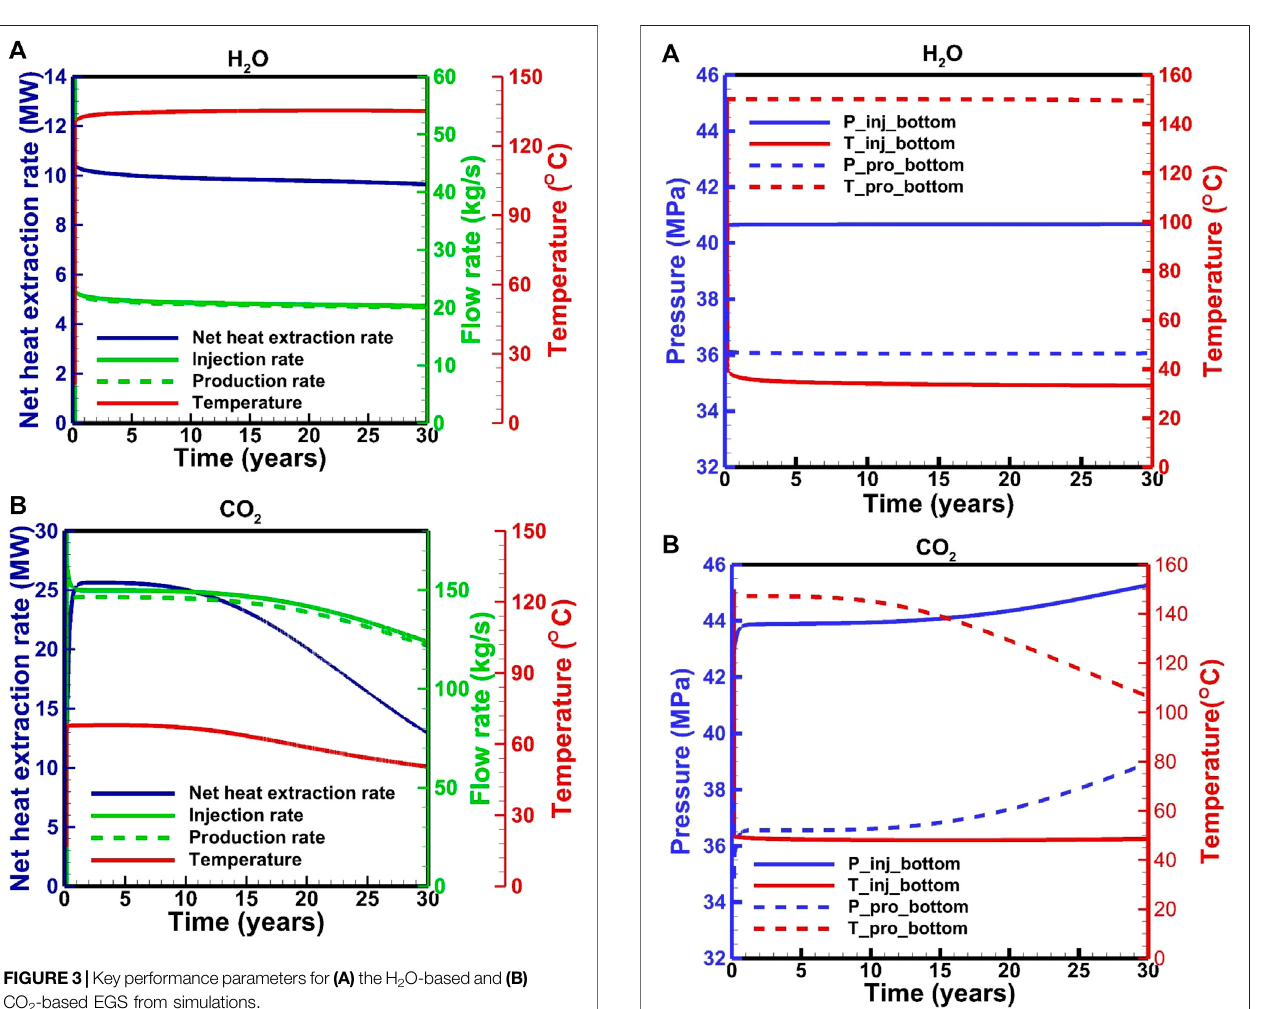
Frontiers in Earth Science |